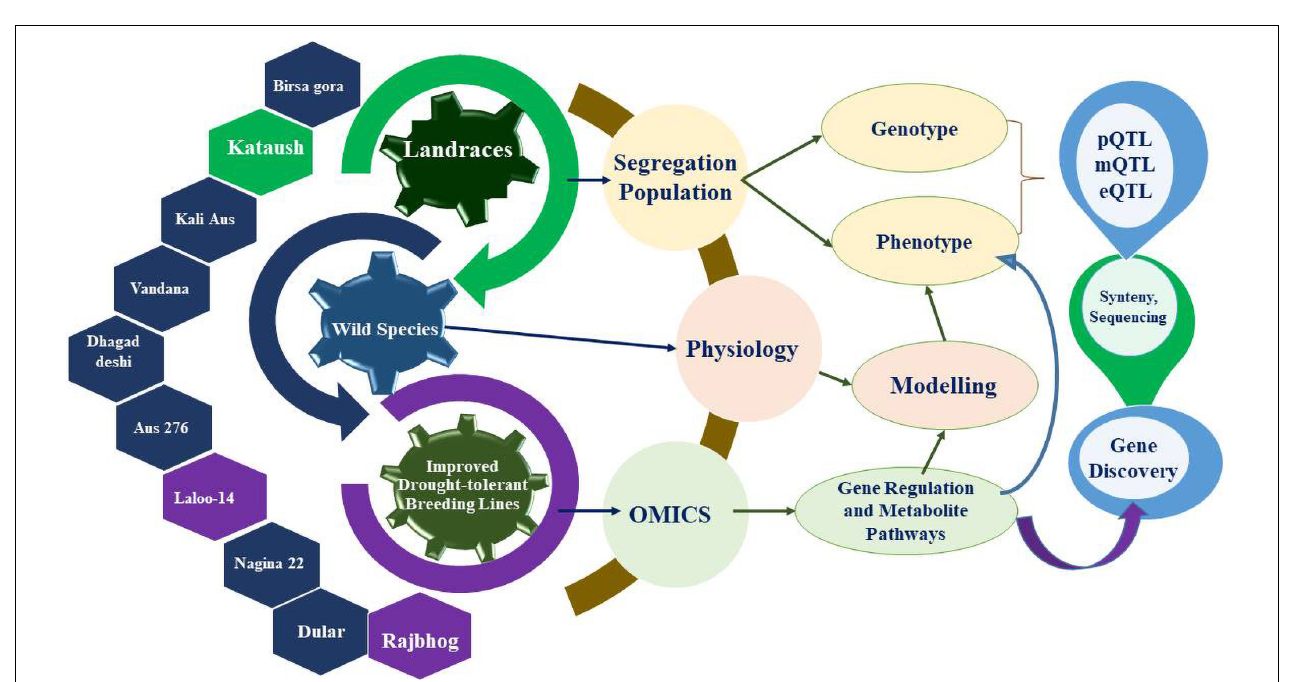
FIGURE 1 | Diagrammatic representation of OMICS approaches employed to unravel the genes/proteins to produce transgenic rice plants.